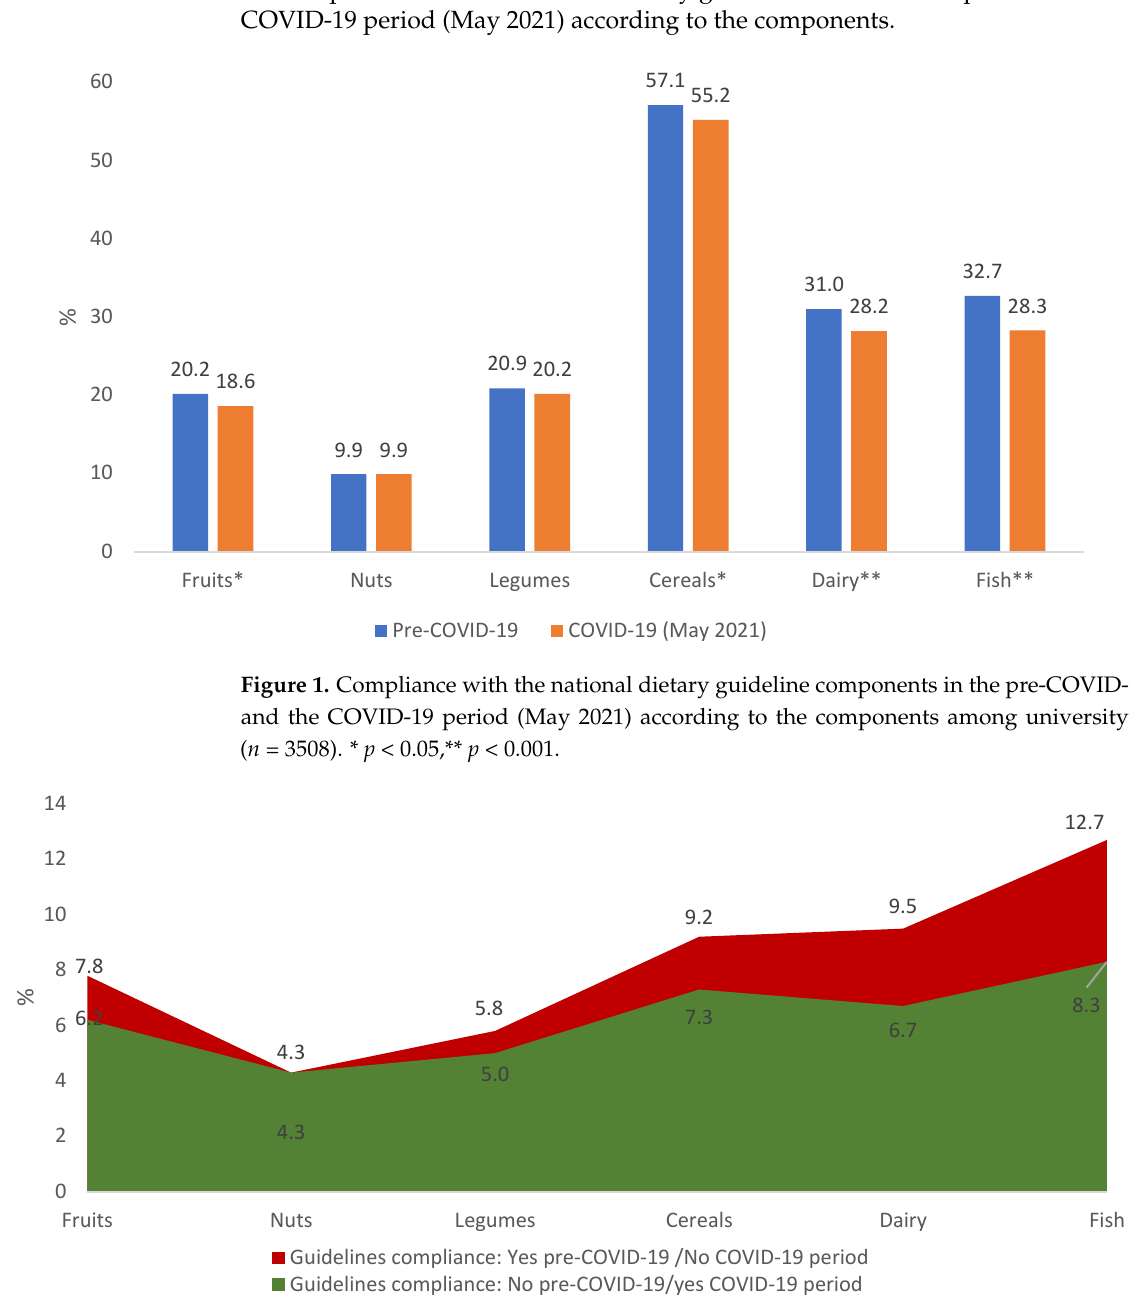
Figure 2. Improving or worsening of the compliance with the national dietary guidelines between the pre-COVID-19 and the COVID-19 period (May 2021) according to the components among university students ( n =